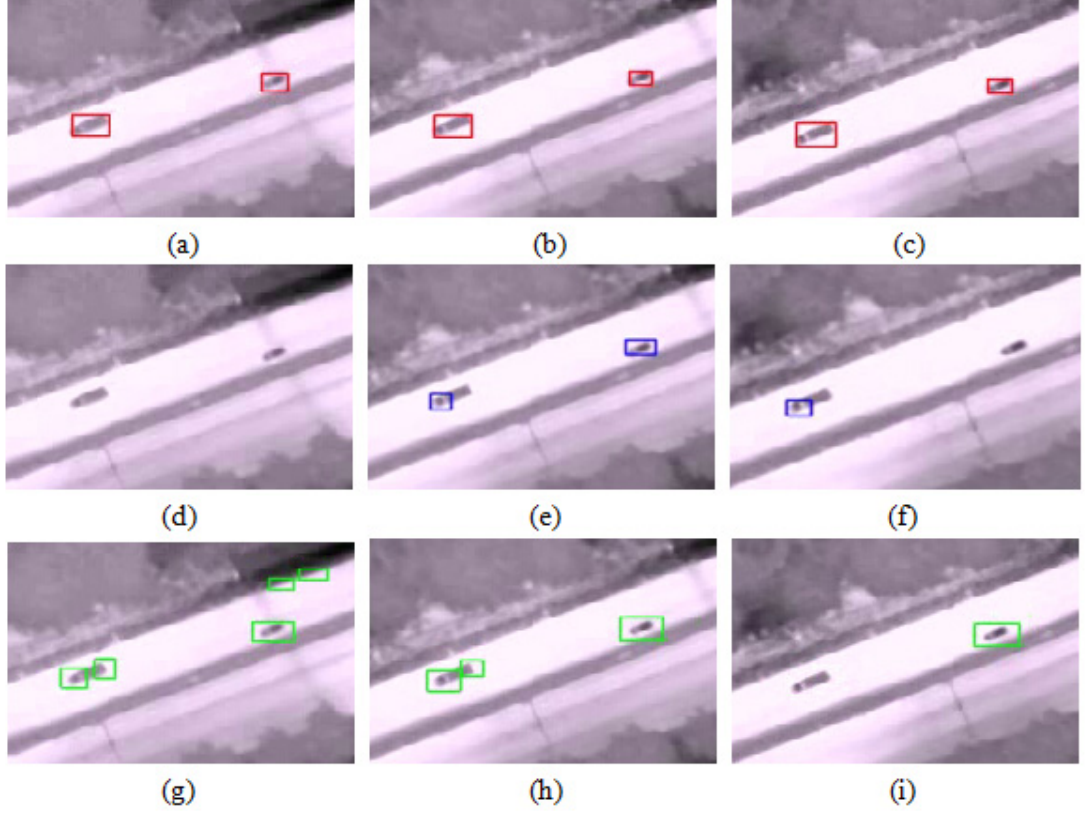
Figure 5. Target detection results for Sequence A. The area range for the detectable targets was set from 80 pixels to 350 pixels. Red rectangles are used in parts ( a – c ) respectively to represent the results obtained using SFDLC for the 10th, 55th and 100th frames; blue rectangles are used in parts ( d – f ) to represent the corresponding results obtained using SFD; and green rectangles are used in parts ( g – i ) to represent the corresponding results obtained using AFD.